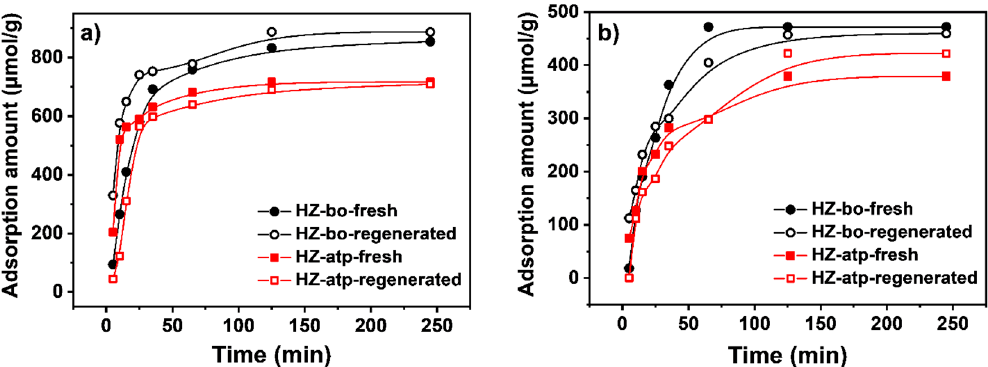
Figure 10. n-Hexane ( a ) and cyclohexane ( b ) adsorption of fresh and generated zeolite extrudates.